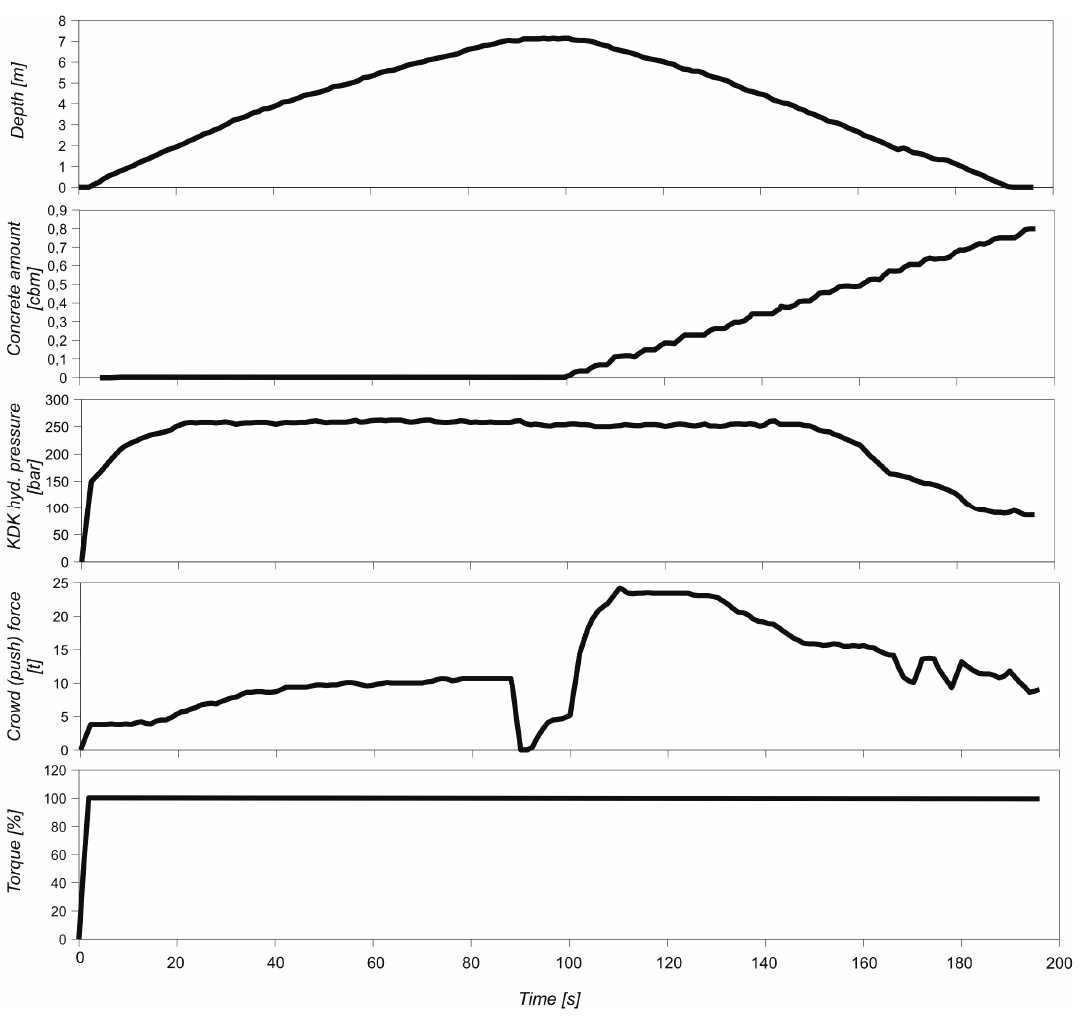
Fig. 6. CMC pile drilling